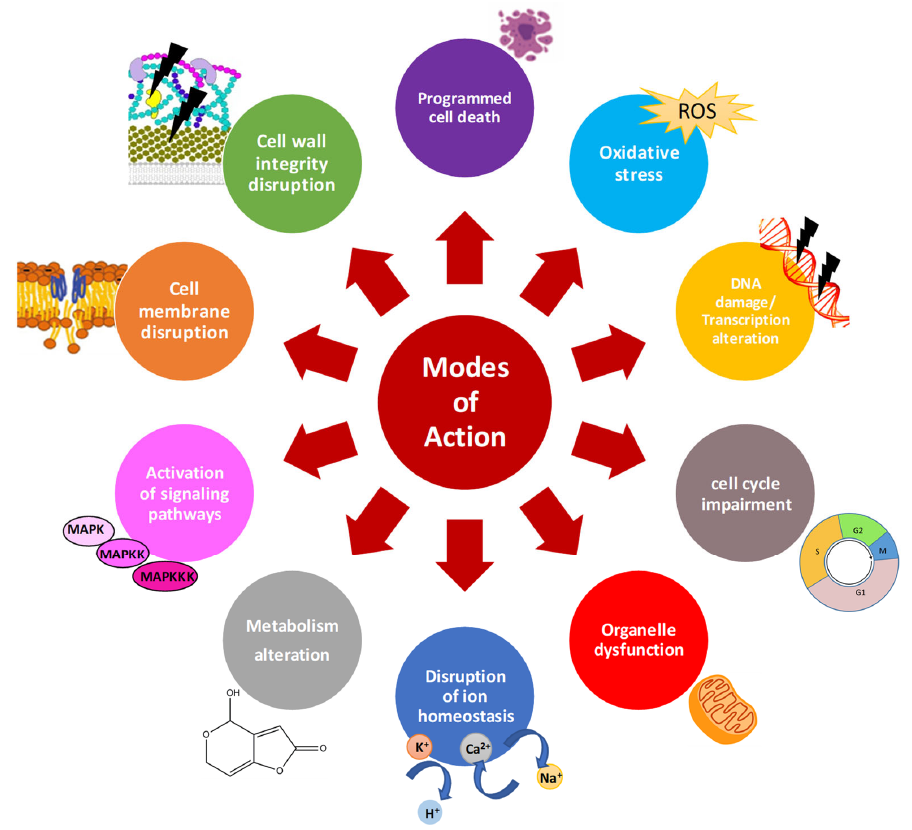
Figure 1. General mode of action of antifungal AMPs.